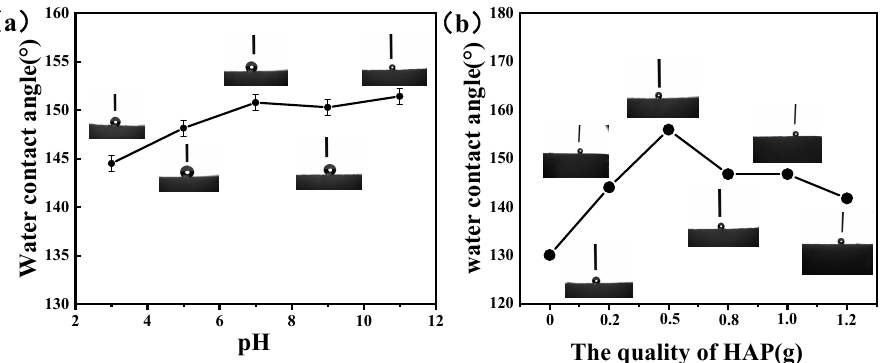
Figure 7. Change in the water contact angle of the nano-HAp/PU sponge after treatment at different pH values ( a ) and quality of HAP ( b ) added. Schematic illustration of the superhydrophobicity and superoleophilicity of the nano-HAp/PU sponge.